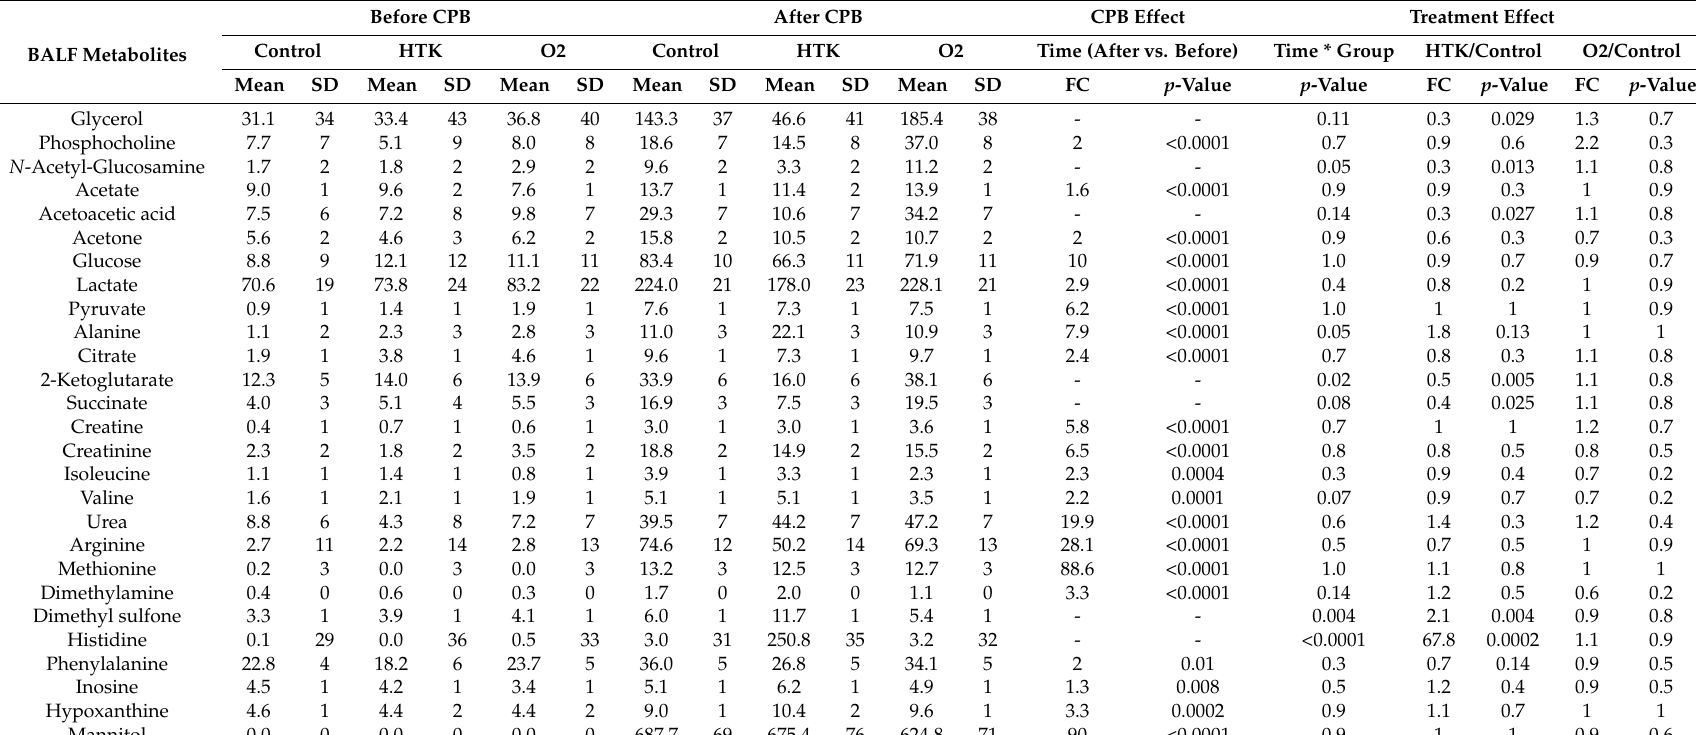
Table 4. Metabolite profiles before and after